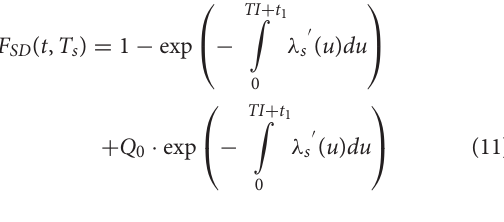
TABLE 3 | Temporal relations of failure in logical gates.